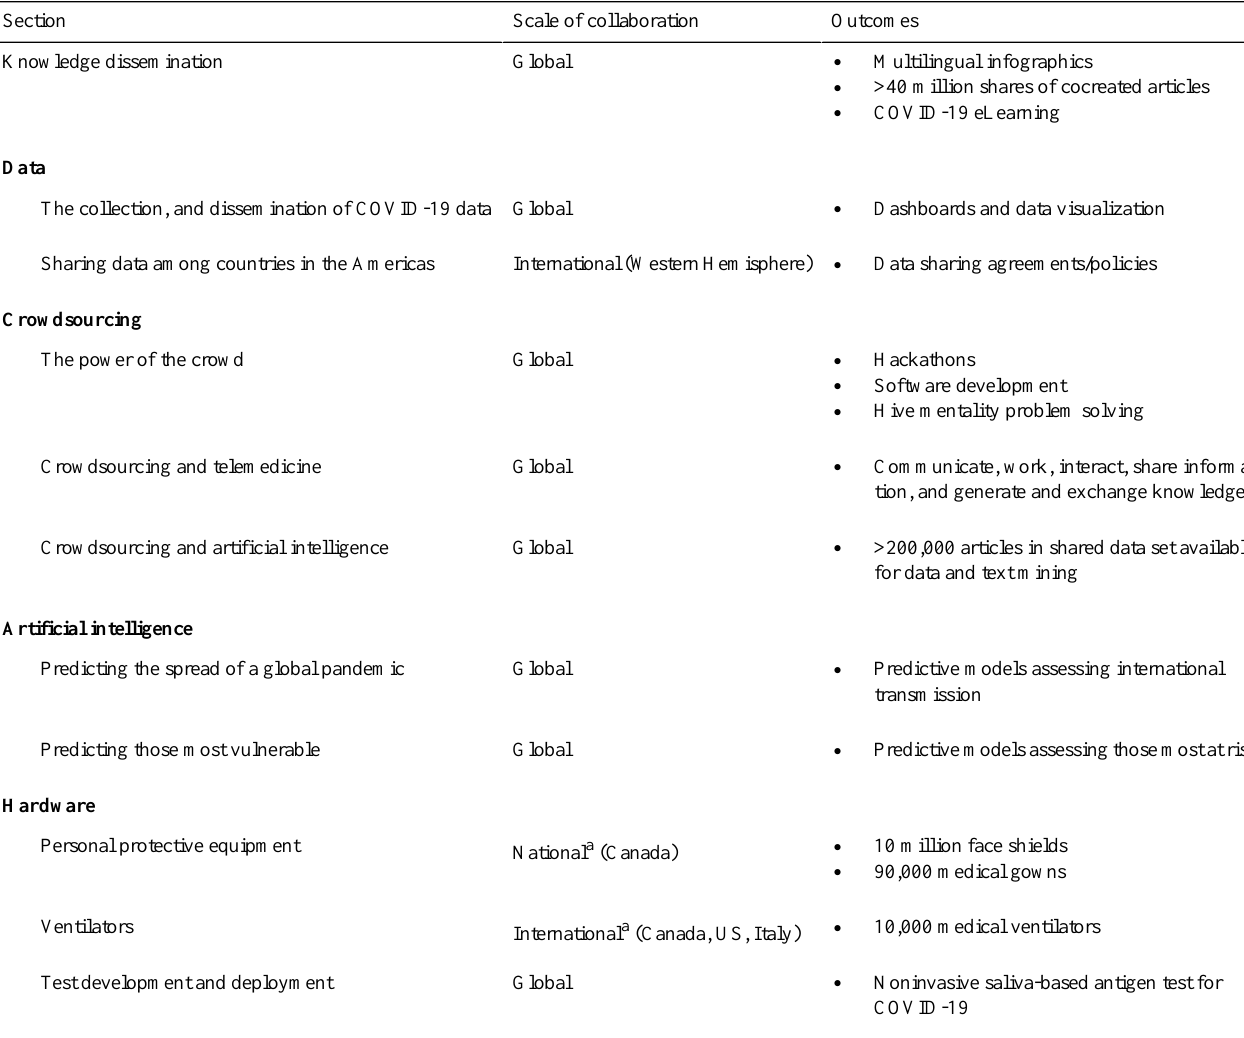
Table 1. Overview of the scope and scale of collaboration to combat